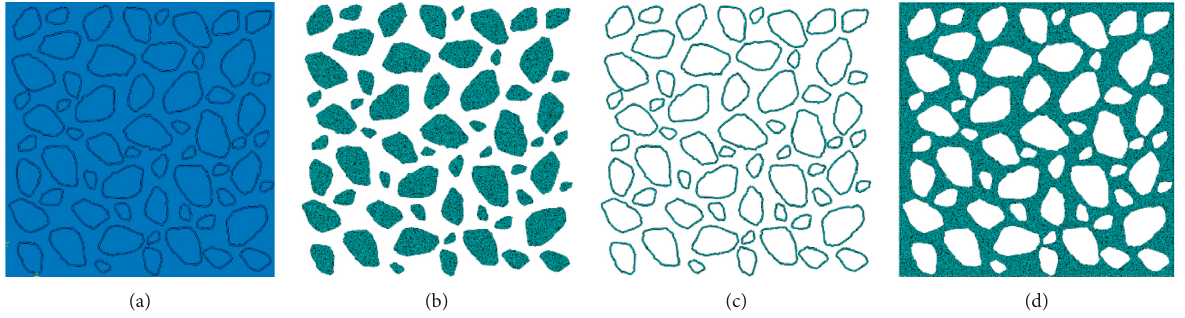
Figure 7: Uniaxial tensile specimen model mesh. (a) Geometric model. (b) Aggregate mesh. (c) Interface mesh. (d) Mortar